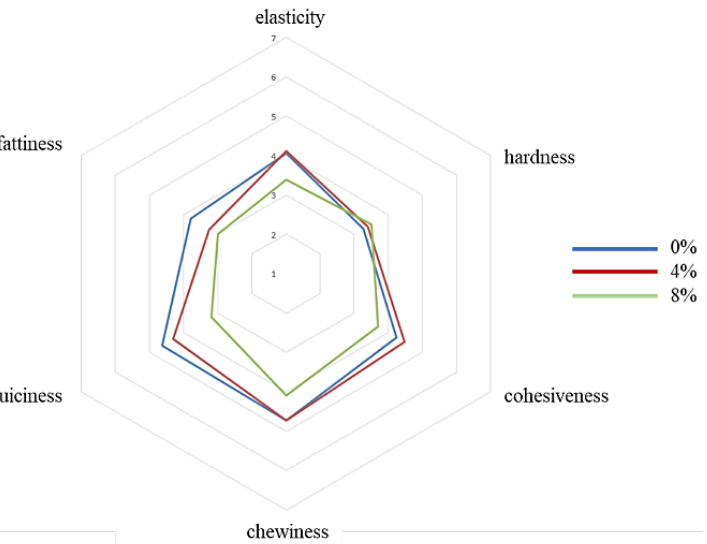
pomace; 8%, burgers added with 8% apple pomace).